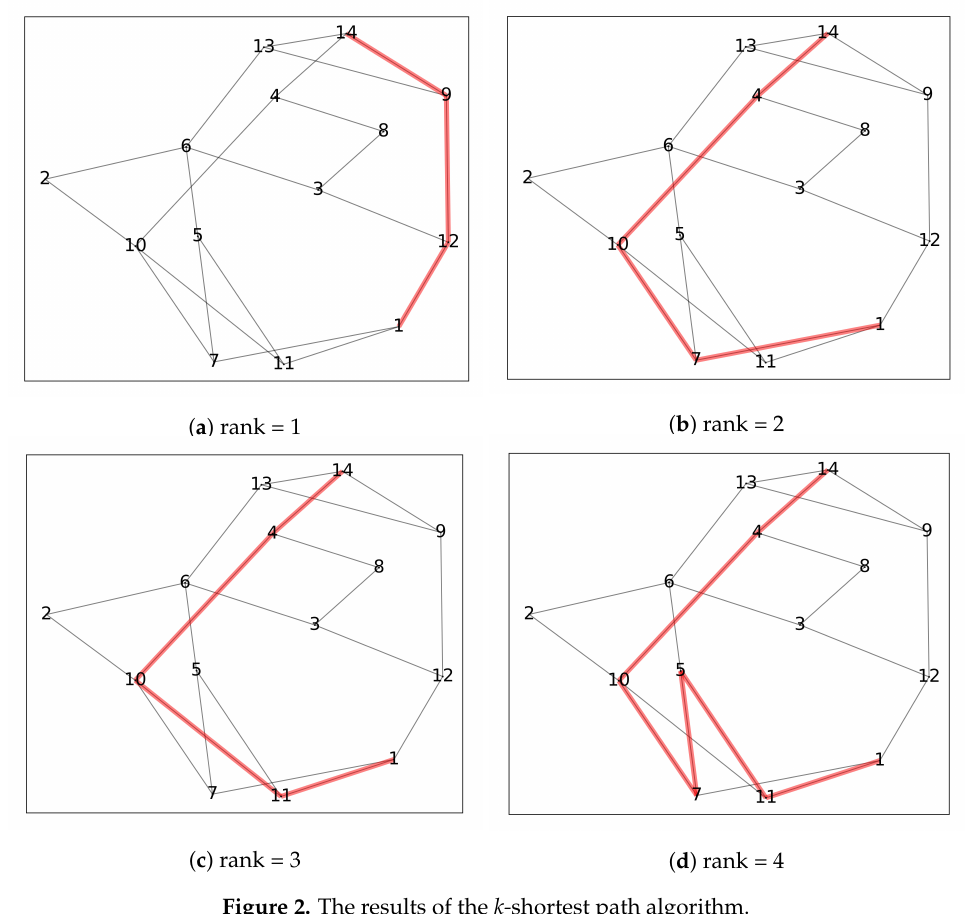
Figure 2. The results of the k- shortest path